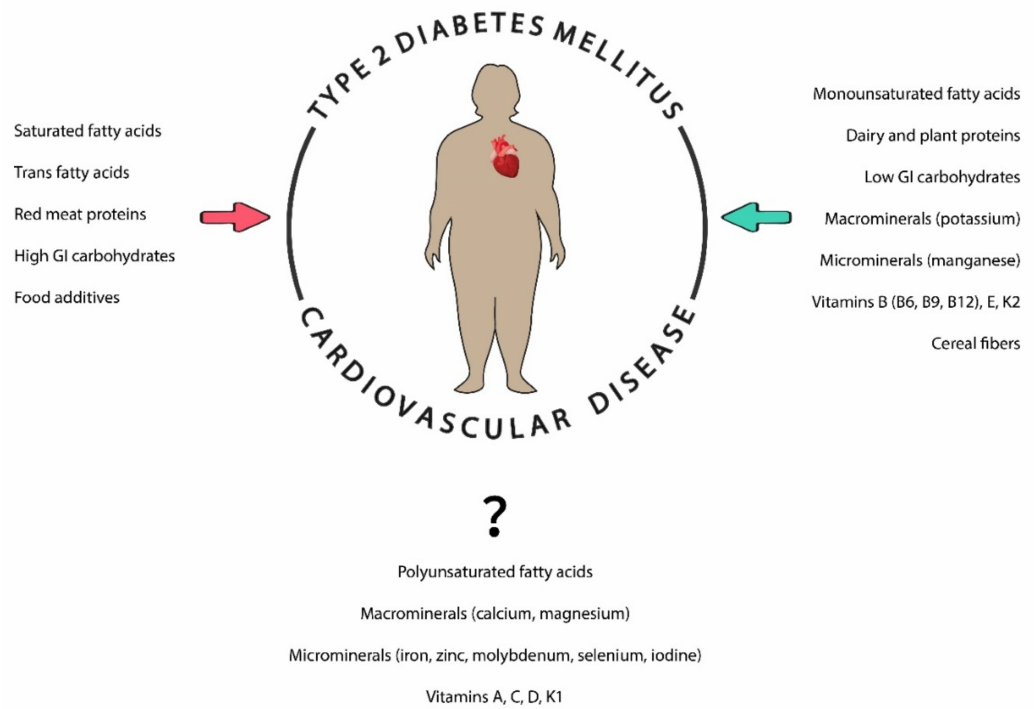
Figure 1. The role of different nutrients in individuals with diabetes and cardiovascular diseases. Nutrients can be beneficial (green arrow) or prejudicial (red arrow) in these patients. GI: glycemic